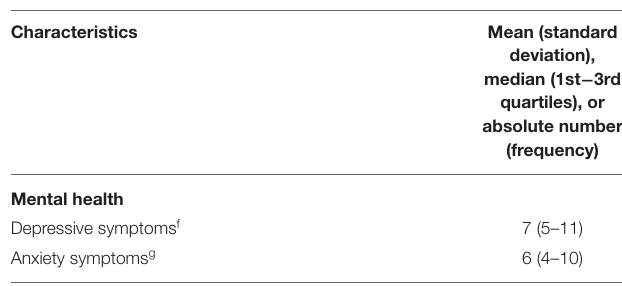
TABLE 1 | Basal characteristics of the study participants ( n =